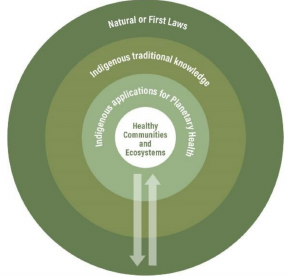
Figure 1. Nested levels of knowledge and applications that surround healthy communities and ecosystems (adapted from